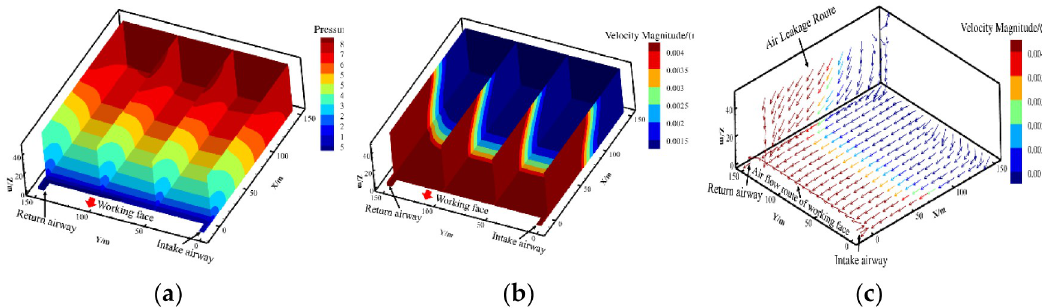
Fig 7. Distribution of the pressure, air leakage velocity and air leakage flow field in goaf. (a) relative pressure; (b) air leakage speed; (c) air leakage flow field.